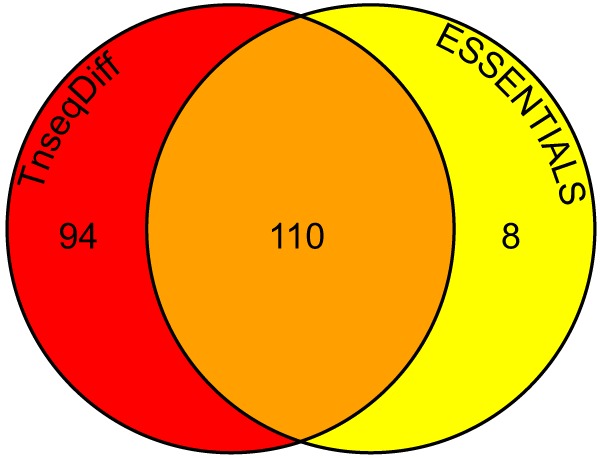
Numbers of INSeq fitness genes determined by TnseqDiff and ESSENTIALS analyses. The number of UMH9 genes having statistically significant (adjusted P < 0.05) fitness defects of ≥2-fold was determined by the TnseqDiff (red) and ESSENTIALS (yellow) programs. The number of fitness genes identified by both methods is in the orange area.